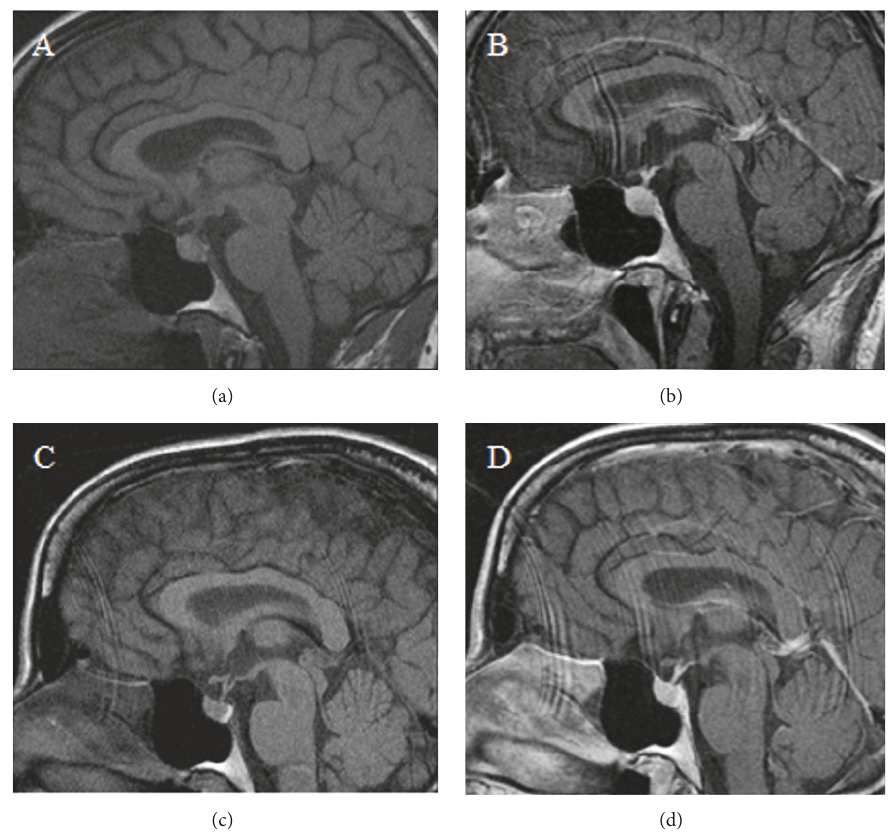
Figure 1: (a, b) Pre- and postcontrast brain MRI images of case 1 show that posterior pituitary bright spot is not visualized. (c, d) Pre- and